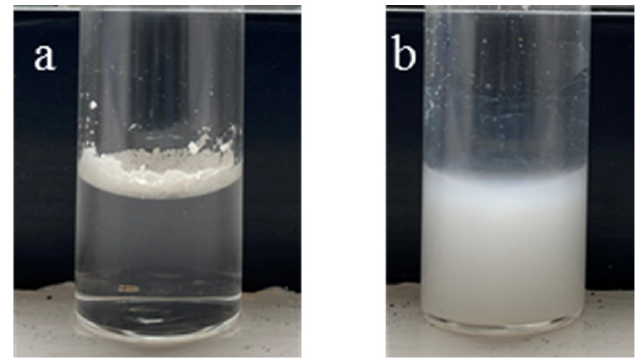
Figure 7. ( a ) Dispersion of as-made UiO-66-NO 2 -25 in water and ( b ) after soaking.